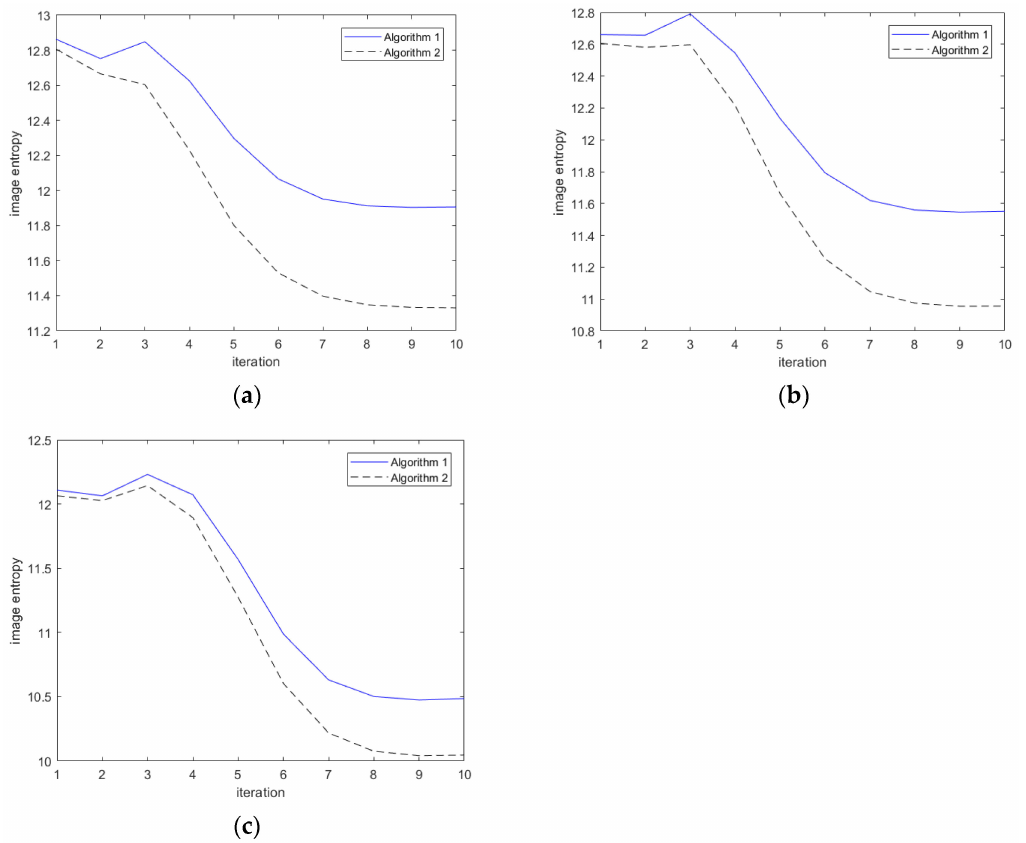
Figure 13. Entropy value change curve of each method in 10 iterations: ( a ) 0.7 echo extraction rate, ( b ) 0.5 echo extraction rate, ( c ) 0.3 echo extraction